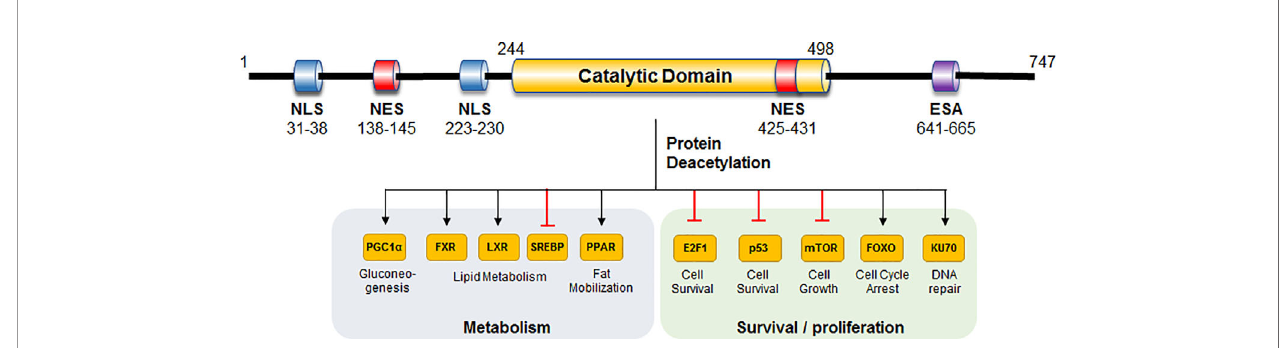
FIGURE 1 | Structure and function of human SIRT1. Important domains and substrates of human SIRT1 are shown, and their corresponding functions are presented. NLS, nuclear localization signal; NES, nuclear export signal; ESA, essential for Sirt1 activity; FXR, farnesoid X receptor; LXR, liver X receptor;